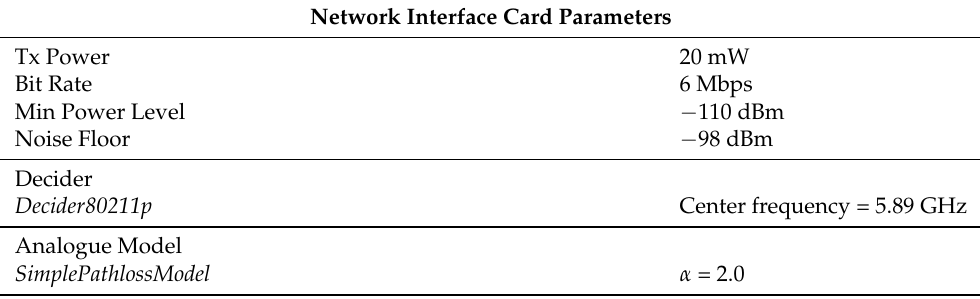
Table 1. OMNeT++ Network Interface Card, 802.11p, specific